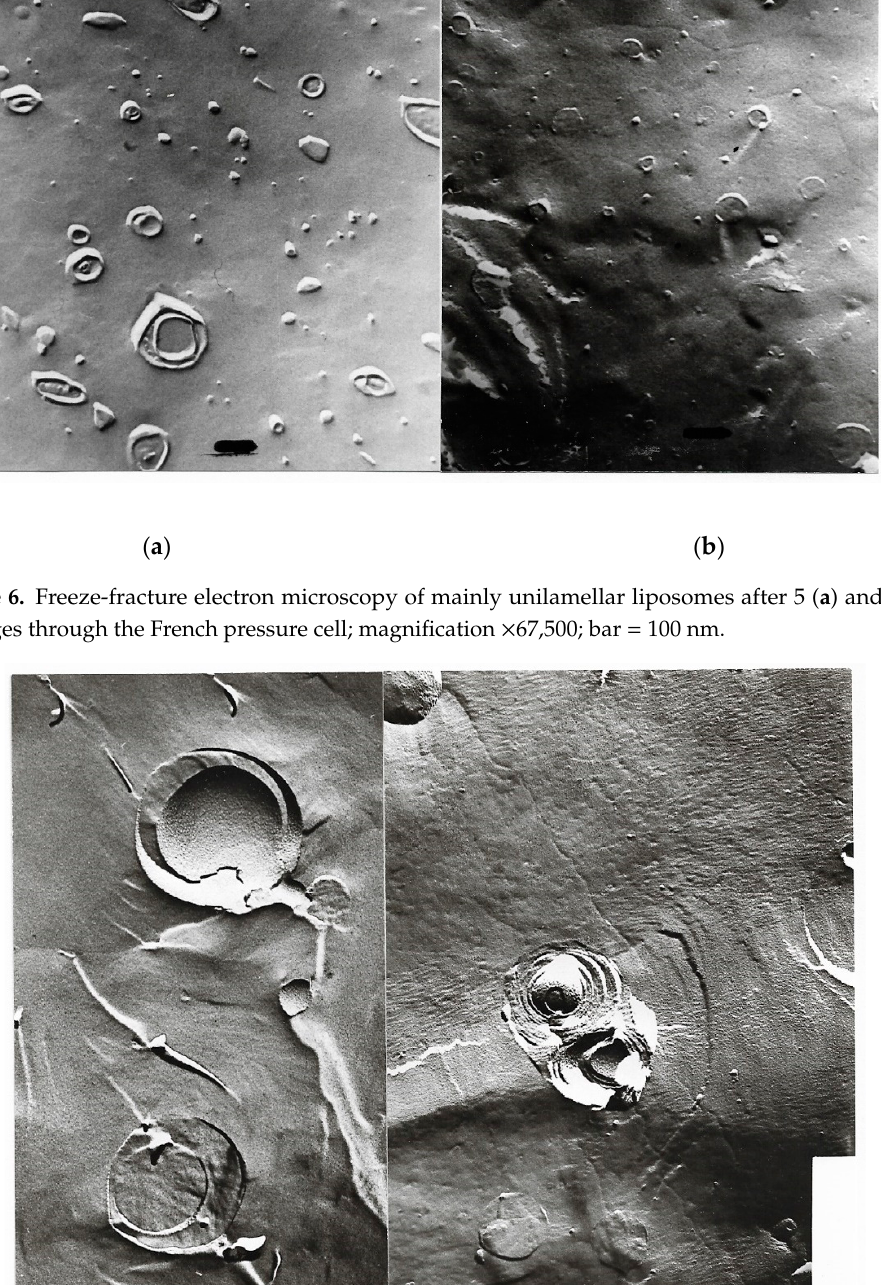
Figure 7. Freeze-fracture electron microscopy of mixed liposomes consisting of 25% MPL and 75% egg lecithin after 89 days; magnification × 67,500; bar = 100 nm.